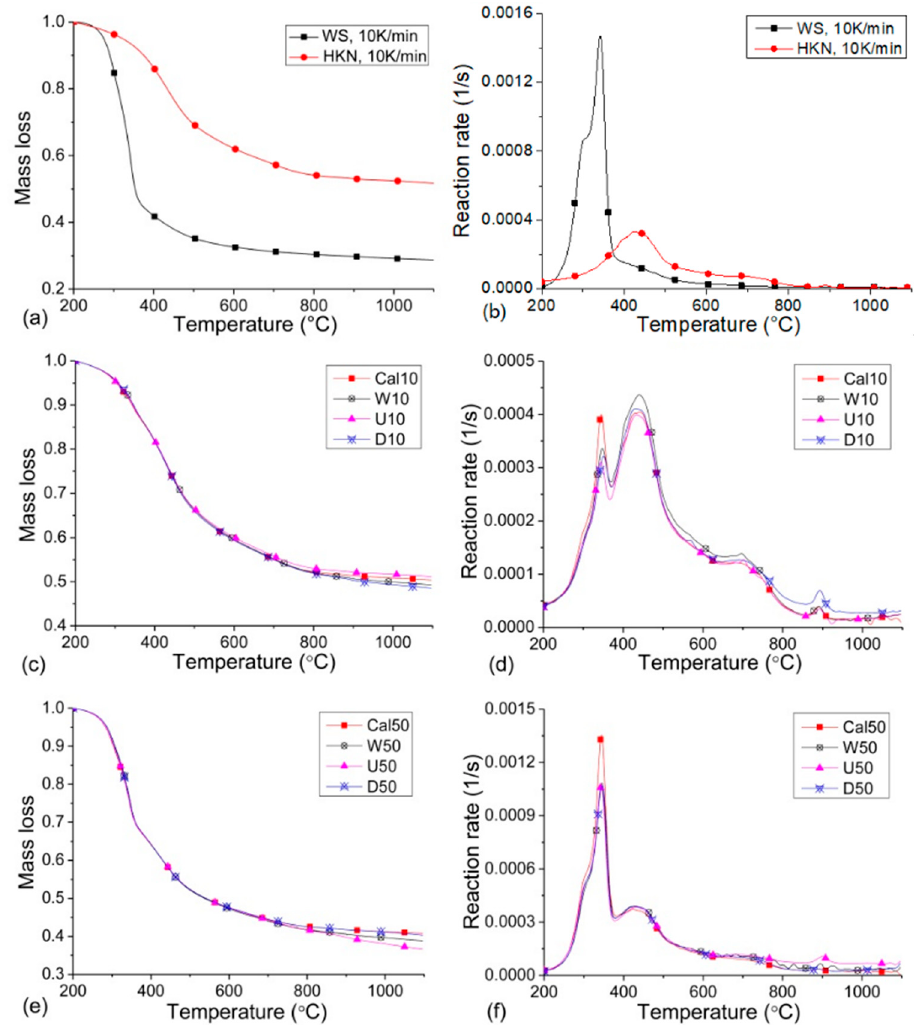
Figure 3. Pyrolysis behavior of single and blended samples: ( a ) mass loss (TG), single fuels, ( b ) reaction rate (DTG), single fuels, ( c ) TG, 10 wt.% samples, ( d ) DTG, 10 wt.% samples, ( e ) TG, 50 wt.% samples, ( f ) DTG, 50 wt.% samples.